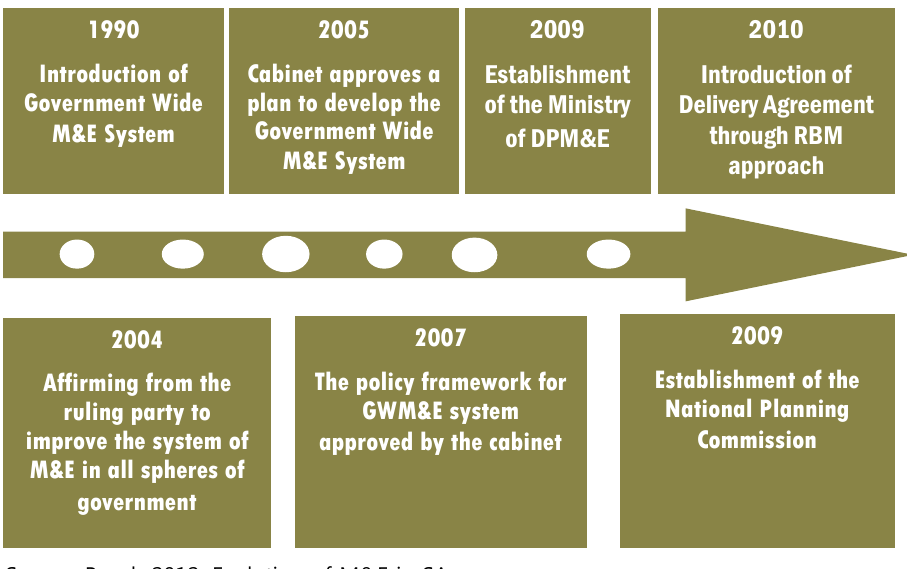
Table 1: Evolution of M&E in South